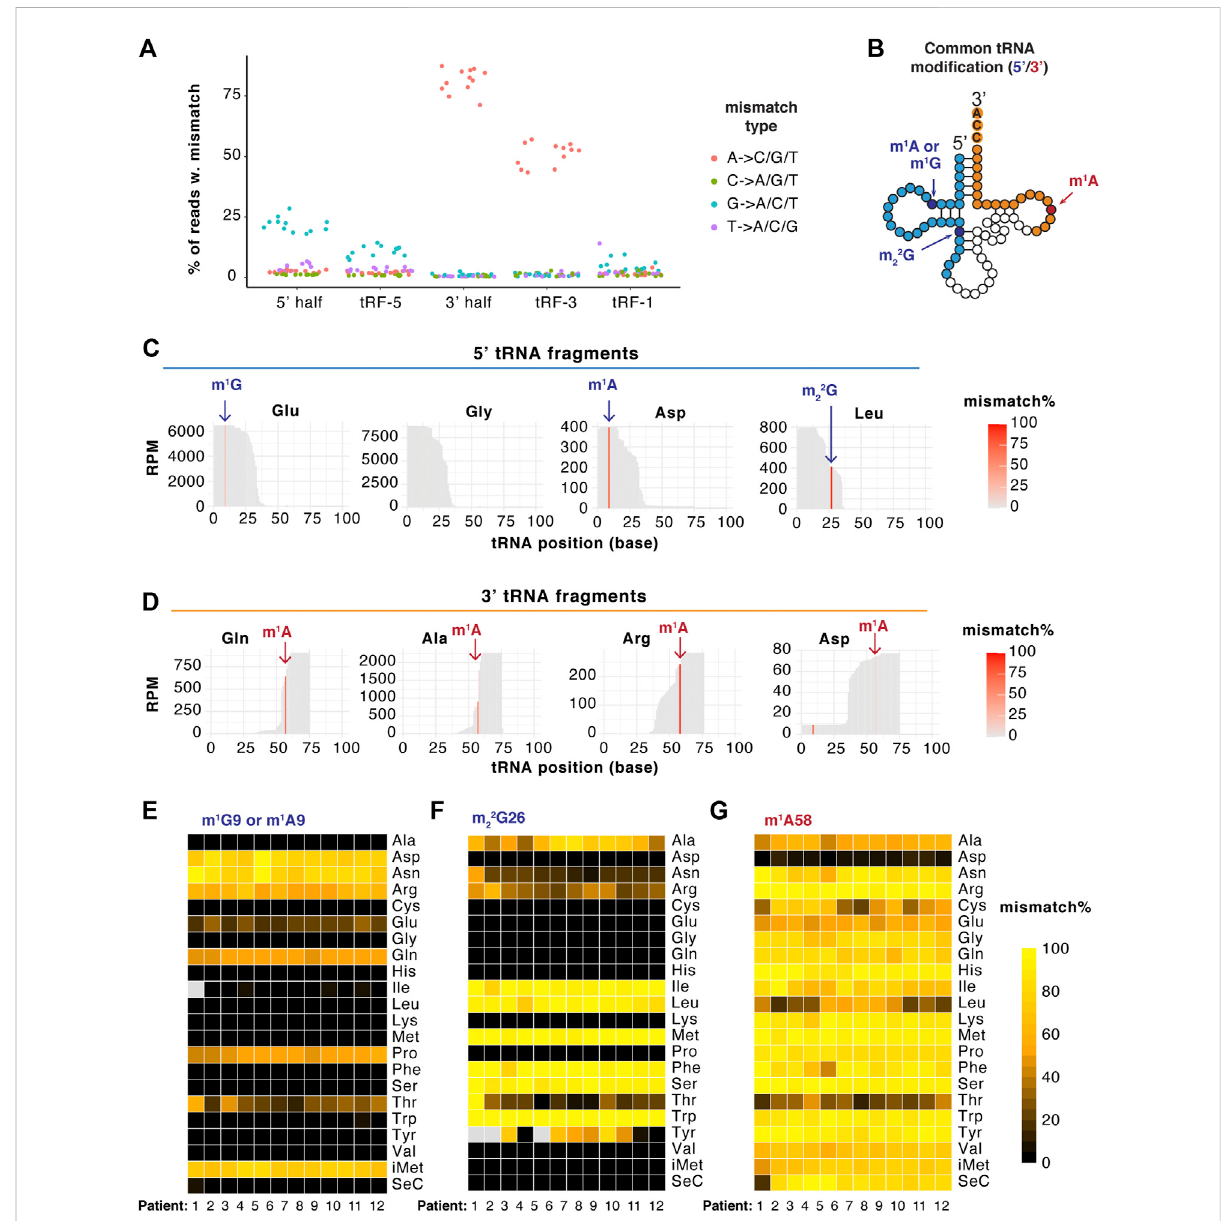
FIGURE 4 TGIRT-seq captures mismatch at speci fi c positions corresponding to RNA modi fi cation sites. (A) A- and G-type mismatch is abundantly detected in tRFs by TGIRT-seq. In particular, A-type mismatch is enriched in 3 ′ fragments while G-type mismatch is enriched in 5 ′ fragments. Each dot represents one patient sample ( n = 12), separated by mismatch types (by color) and tRF types ( X -axis). Y axis represents the percentage of reads that contain speci fi c type of mismatch. (B) Scheme of known common tRNA modi fi cations that are detected on tRFs by TGIRT. (C,D) Example coverage plot of 5 ’ (C) and 3 ’ (D) tRNA fragments with mismatch positions highlighted at each position (patient #1 shown as example). (E – G) Heatmap of tRF mismatch index (percentage) at speci fi c positions representing m 1 G/A9 (E) , m 2 2 G26 (F) and m 1 A58 (G) . All tRF reads are combined and clustered on the length of parental tRNAs. Each column represents one tumor sample ( n = 12). Grey squares represent no read coverage at that